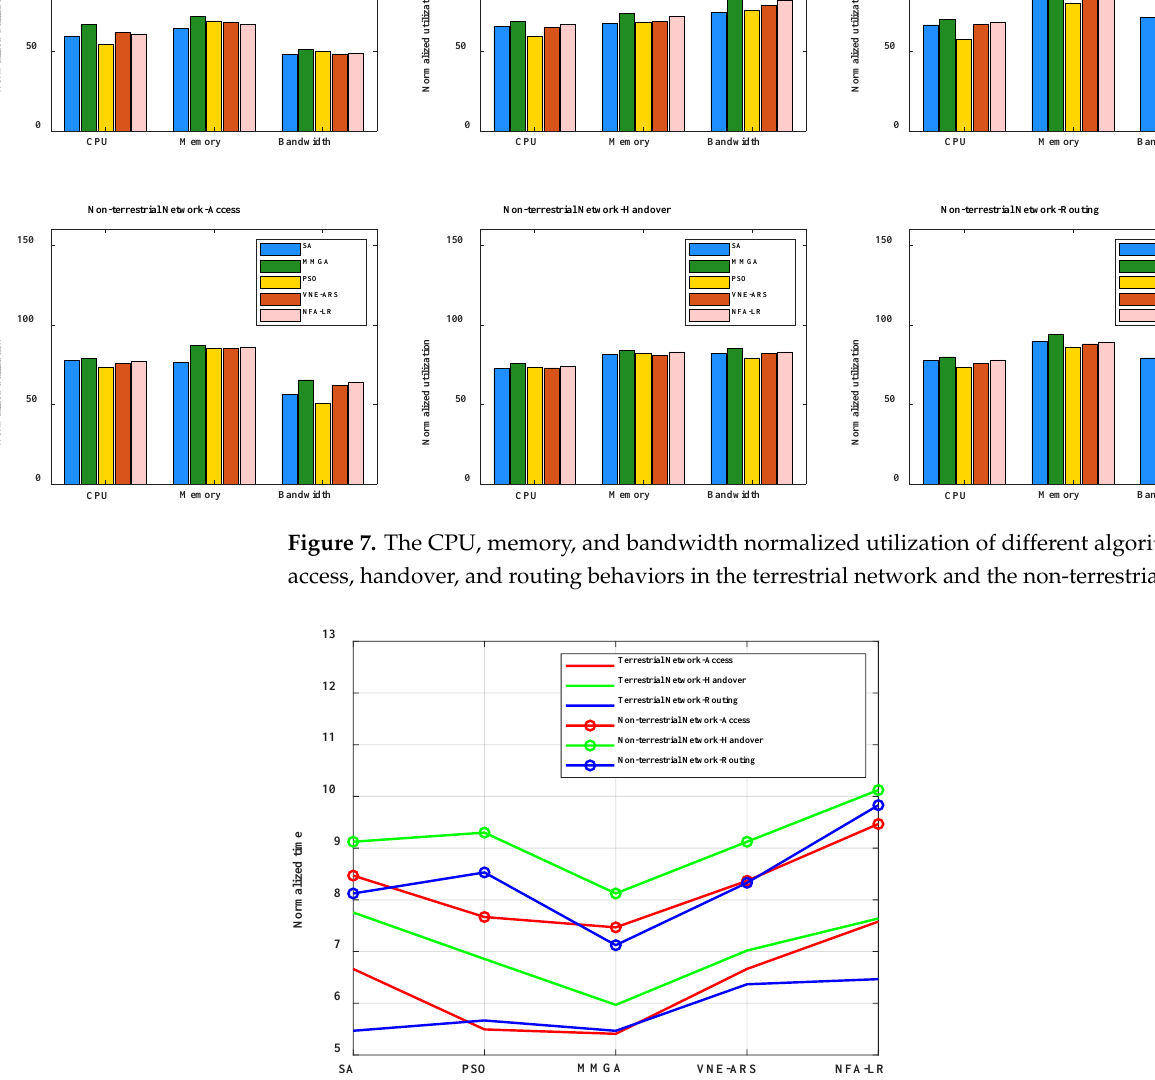
Figure 8. Normalization time consumed for different algorithms.